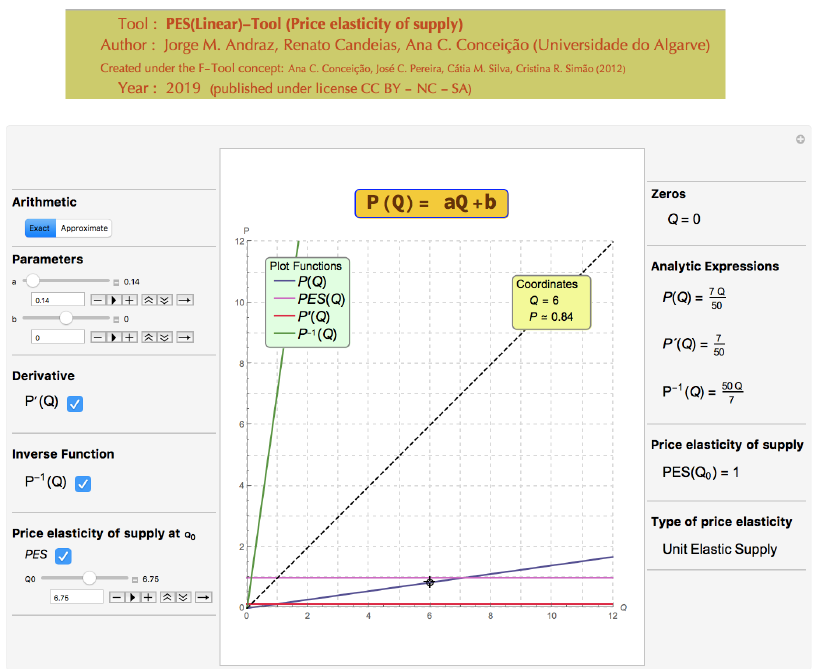
Figure 11. Example of an unit elastic supply with a derivative value below